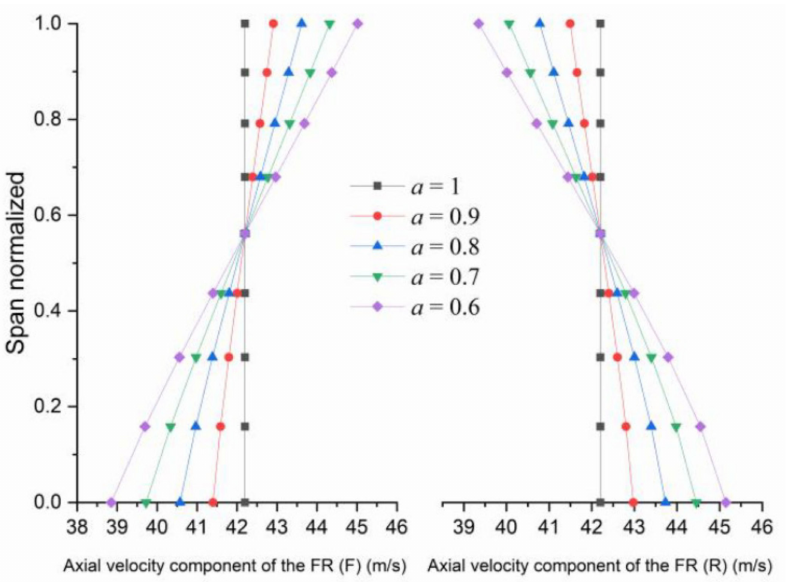
Figure 4. Axial velocity component code results of the FR (F) and FR (R) at the